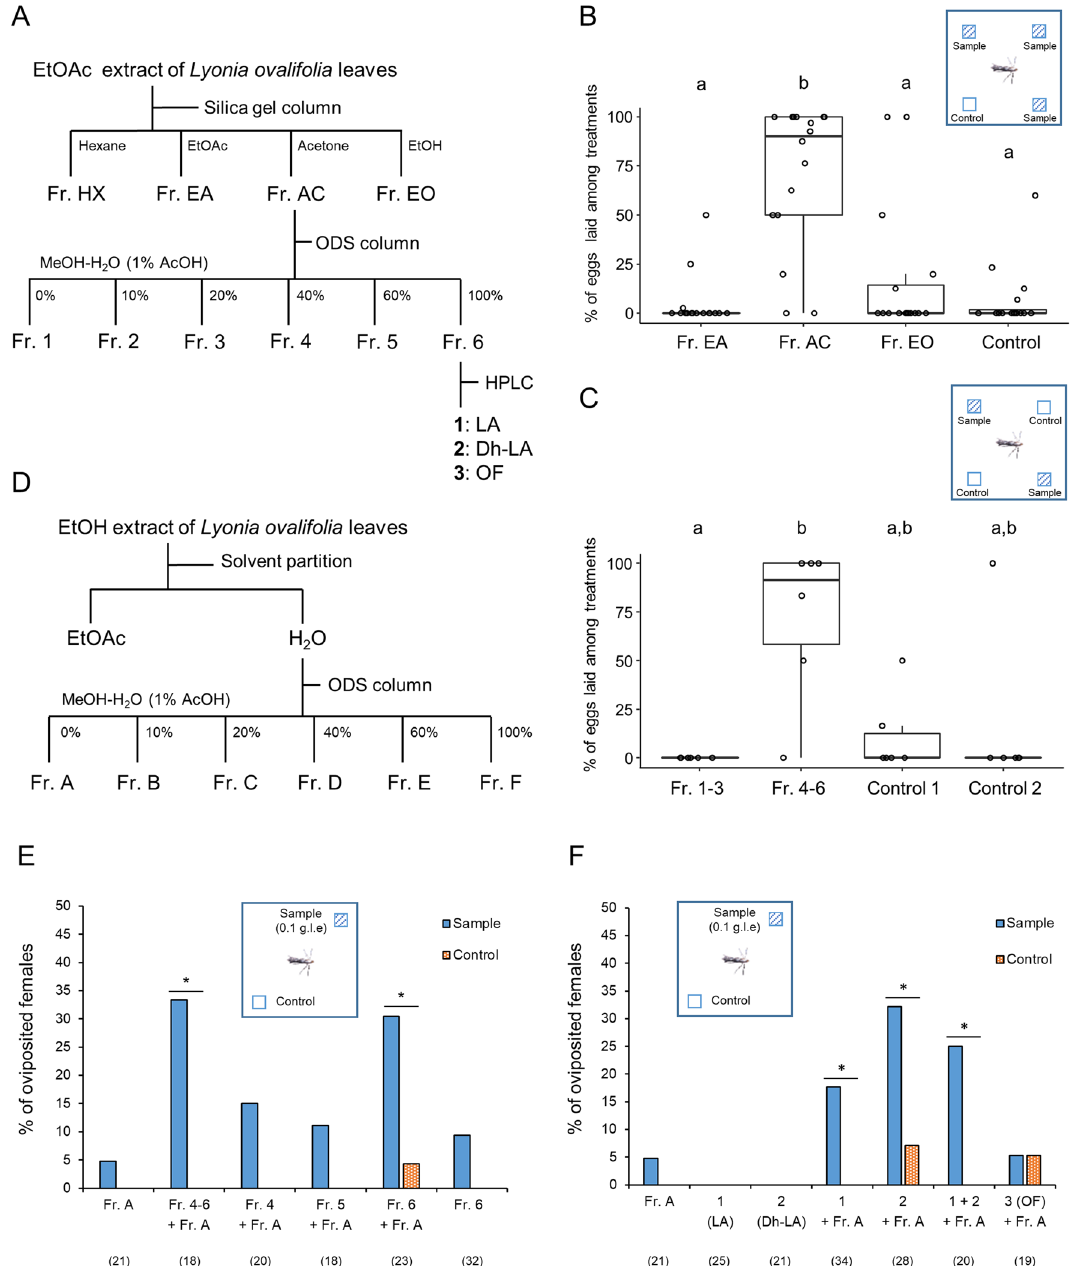
Figure 3. Separation procedure and oviposition stimulant activities of Lyonia ovalifolia fractions for Lyonia race females. ( A ) Separation procedure to isolate triterpene glycosides. ( B ) Percentage of the eggs laid by individual females on cover glasses treated with or without fractions separated using silica gel column chromatography. Different letters indicate statistically significant differences among the treatments by Steel–Dwass test, * p < 0.01 ( n = 16). ( C ) Percentage of the eggs laid by individual females on cover glasses treated with or without fractions separated using ODS column chromatography. Different letters indicate statistically significant differences among the treatments by Steel–Dwass test, * p < 0.01 ( n = 6). ( D ) Separation procedure to prepare the highly polar fraction (Fr. A). ( E ) Percentage of Lyonia race females oviposited on cover glasses treated with or without samples in two-choice assays. A significant difference between the sample and control was analyzed within each two-choice set by Fisher’s exact test, * p < 0.05. Numbers in parentheses represent the number of tested animals. ( F ) Percentage of Lyonia race females oviposited on cover glasses treated with or without samples in two-choice assays. A significant difference between the sample and control was analyzed within each two-choice set by Fisher’s exact test, * p < 0.05. Numbers in parentheses represent the number of tested